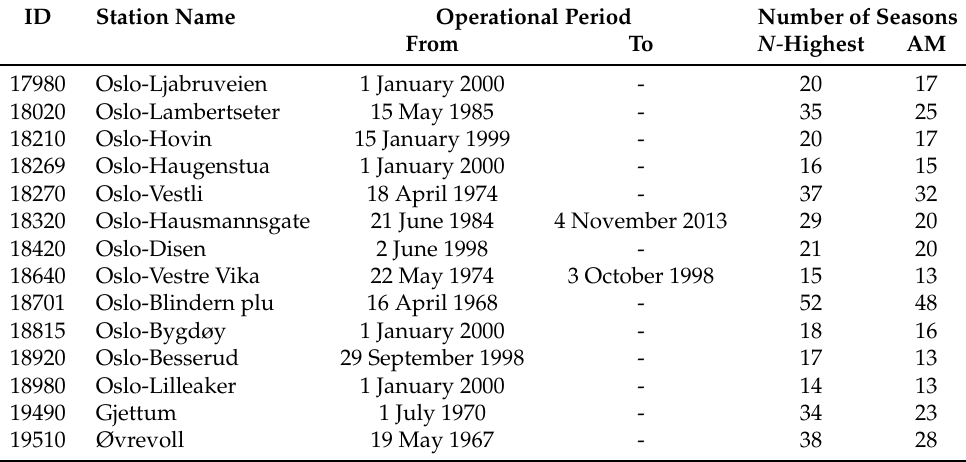
Figure 1. Map of tipping bucket pluviometer stations (red dots) in the general Oslo area. Numbers above the dots indicate the station ID, and numbers below the dots indicate the height above sea level in meters. Black dots (18700 and 18950) show weight gauges used for analysing monthly maximum precipitation (see Section 2.1.2). The reference pluviometer at MET Norway is 18701 Oslo-Blindern. Table 1. Station IDs, station names, and the time period in operation. N -highest: N -highest measurements for each duration, N being the number of years; AM: annual maxima for each duration.